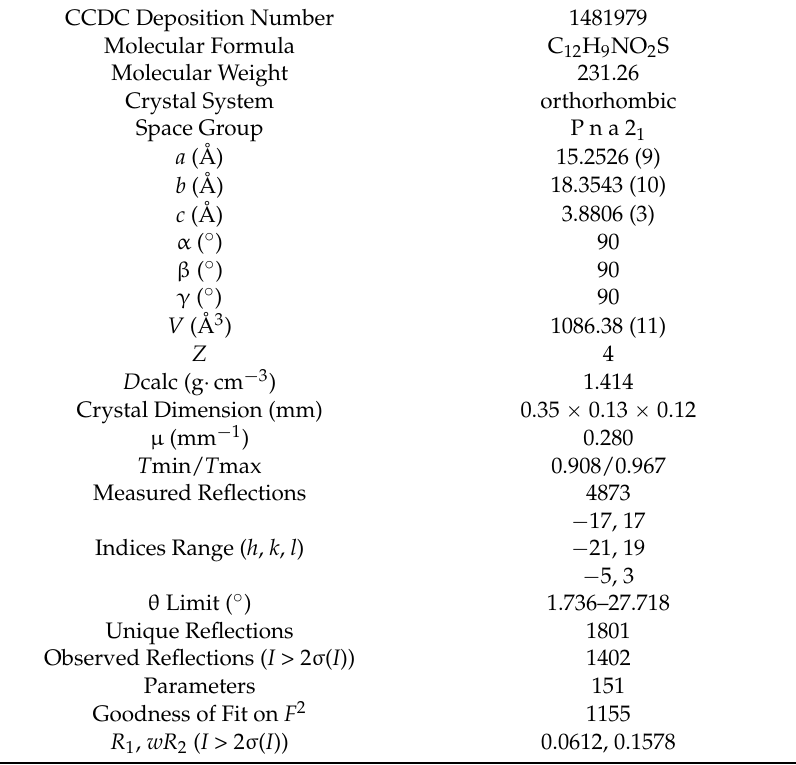
Table 1. Crystal data and refinement parameters for C 12 H 9 NO 2 S.